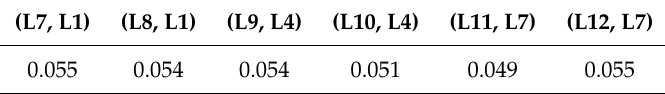
Table 8. Drift Values Measured in ◦ · s − 1 , of the Walk of Figure